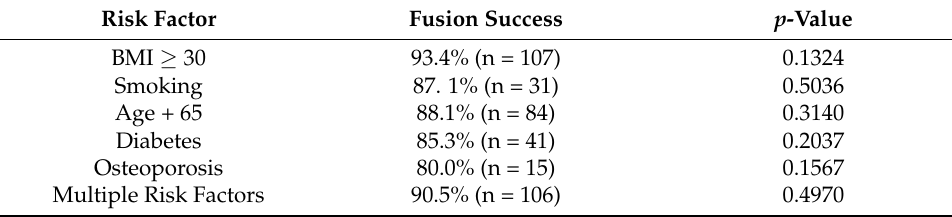
Figure 2. Spinal fusion success. One-year postoperative CT scan demonstrating successful bridging bone on sagittal and coronal reconstructions. Table 3. Fusion Success Rate by Risk